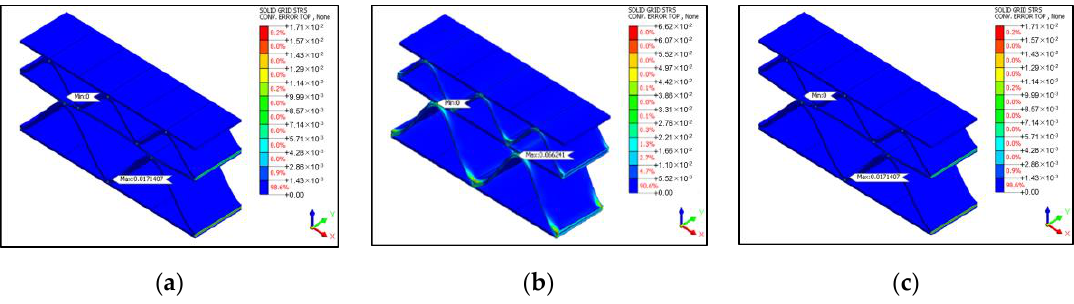
Figure 9. Mesh convergence error for shear displacement analysis (example: AB/F-DW), they should be list as: ( a ) XY-direction (1.90%); ( b ) YZ-direction (6.62%); ( c ) ZX-direction (2.02%). Table 2. Mesh Convergence Error (%).